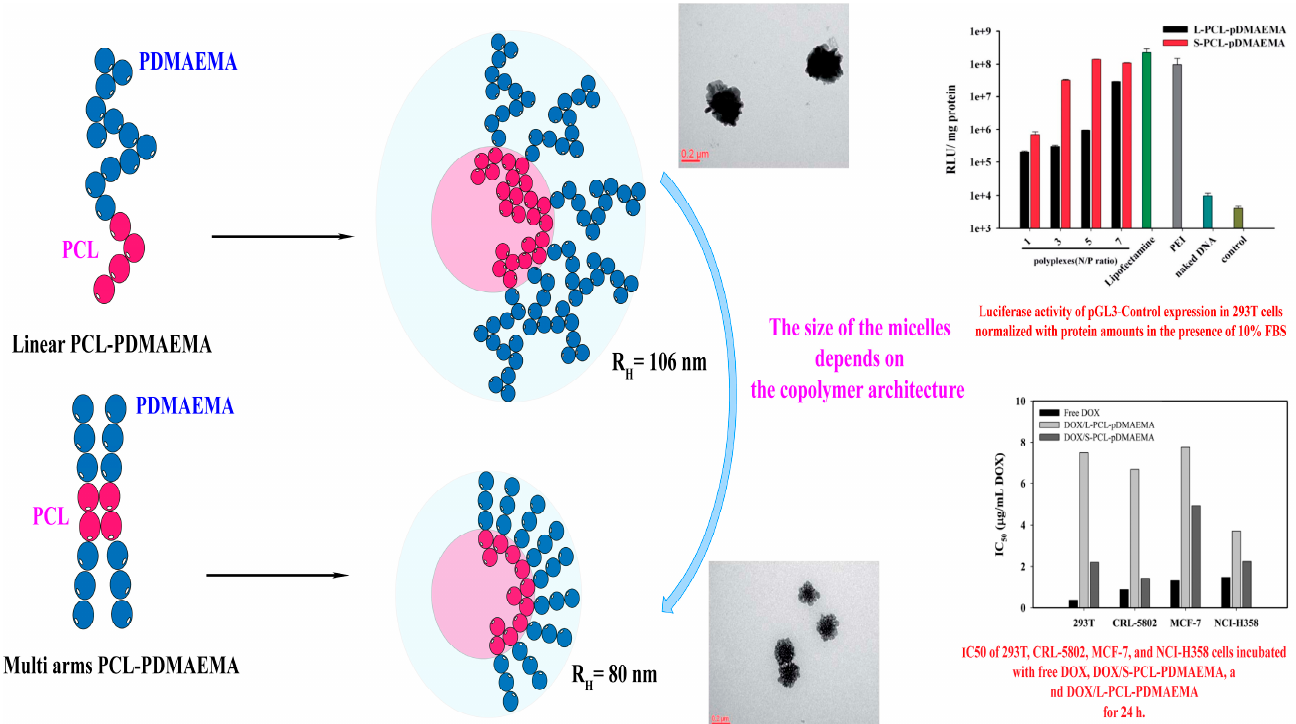
Figure 18. Schematic illustration of hydrodynamic radius changes as a function of PCL-b-PDMAEMA copolymer topology; Adapted from [203] (Copyright 2014, The Royal Society of Chemistry).